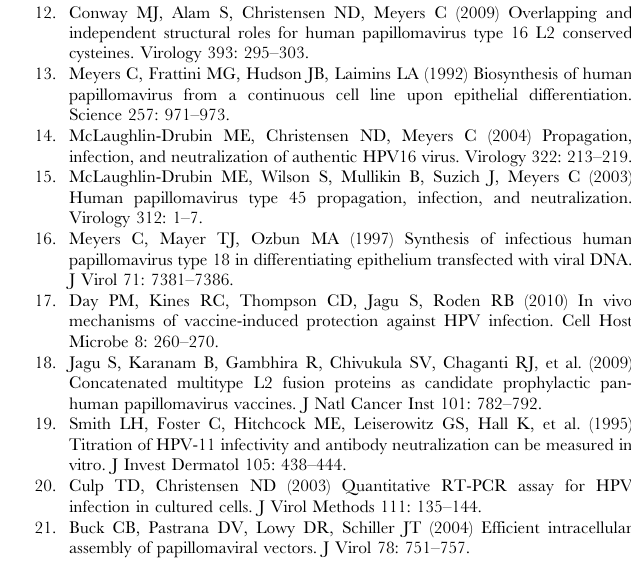
Table S2 Primer sequences for DNA encapsidation assays.